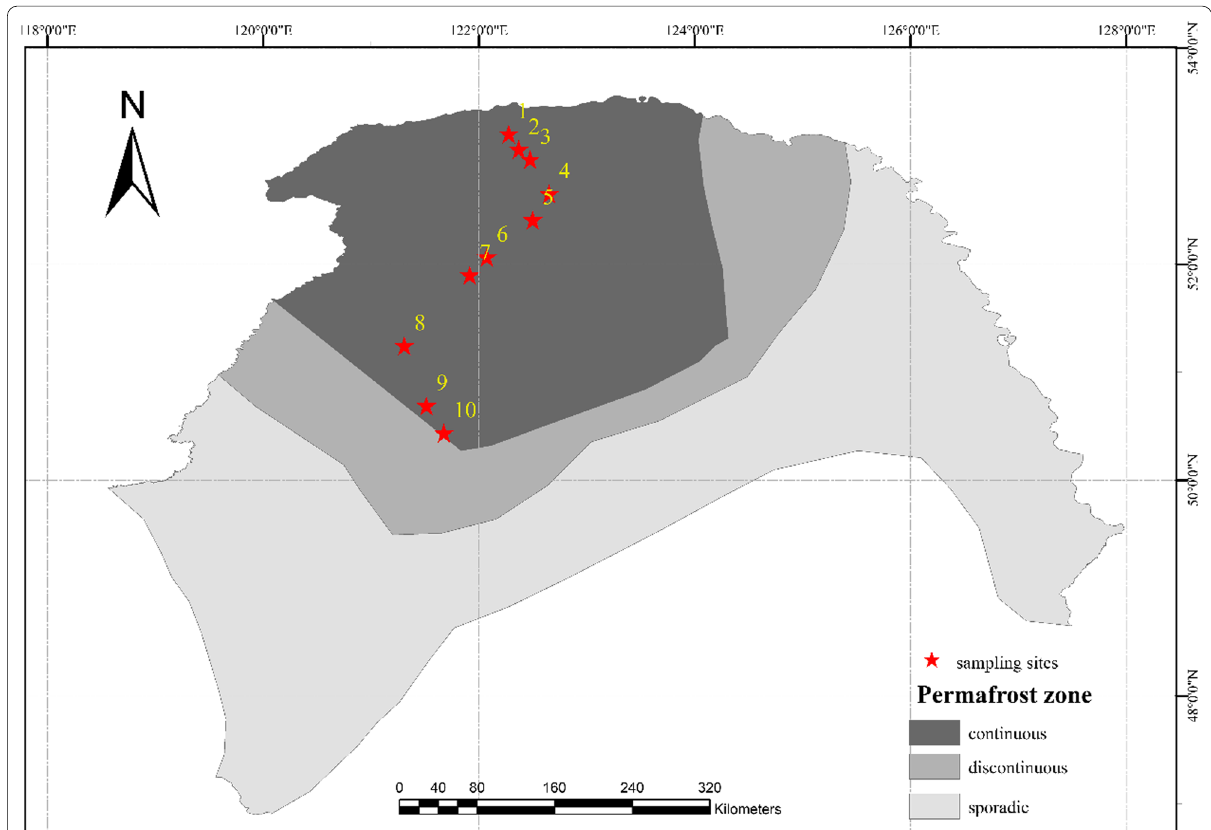
Fig. 1 Study area and location of the 10 sampling sites in the continuous permafrost region of northeastern China. The map in this figure was generated by ArcGIS 10.2 (ESRI, Redlands, CA, USA, http:// resou rces. arcgis. com/ en/